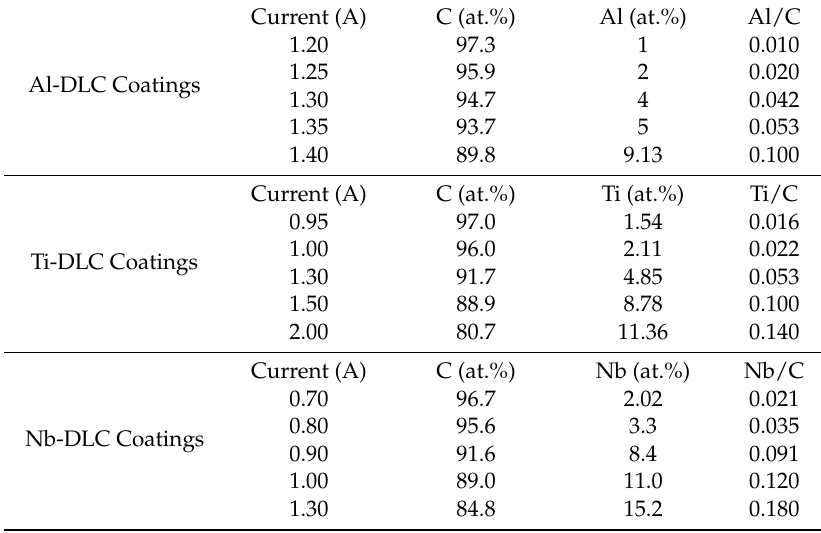
Table 3. Energy dispersive spectroscopy (EDS) composition of Me-DLC coatings.